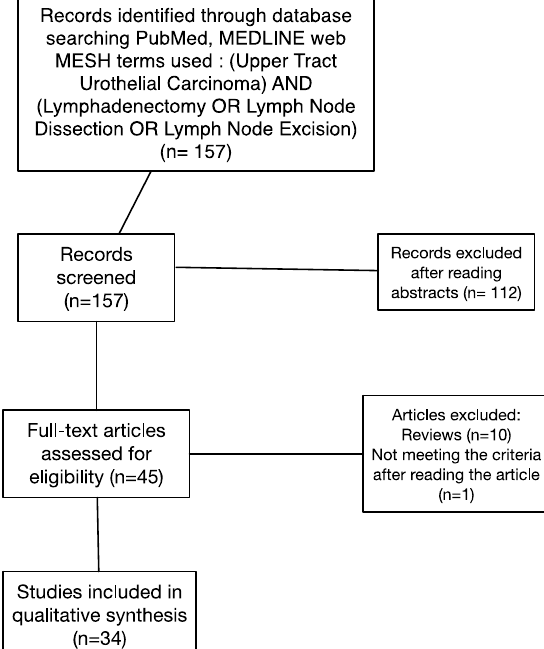
Figure 1. Flow chart.